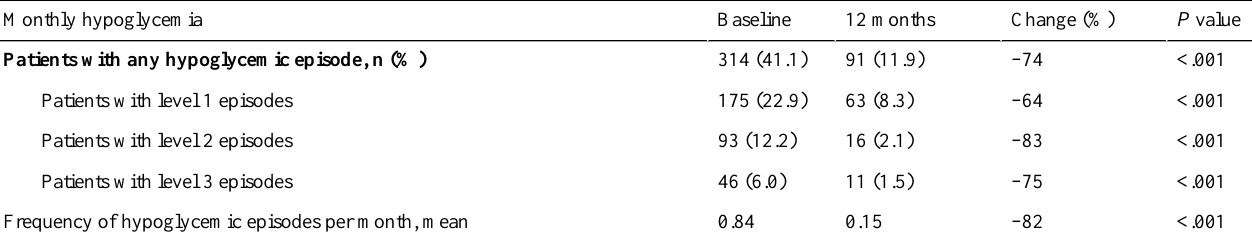
Table 9. Changes in hypoglycemic events over 1 year in digital medicine patients